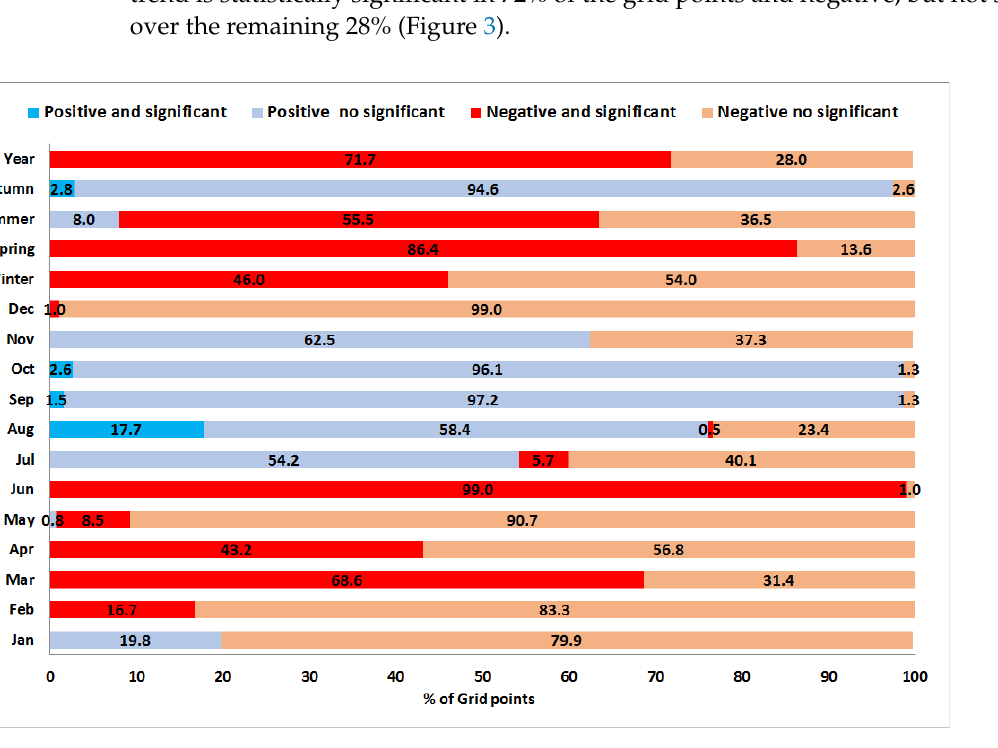
Figure 3. Percentages of grid points presenting positive or negative and significant or non-significant trends at yearly, seasonal and monthly time scales.